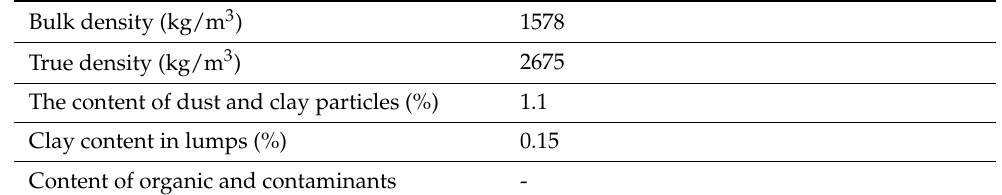
Table 3. Physical properties of sand.